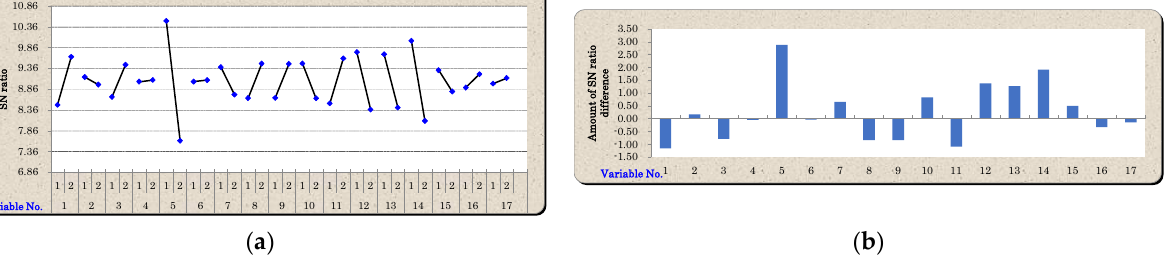
Figure 8. ( a ) SNR Plot and ( b ) SNR Gain Chart for Medical Diagnosis of Liver Disease dataset.